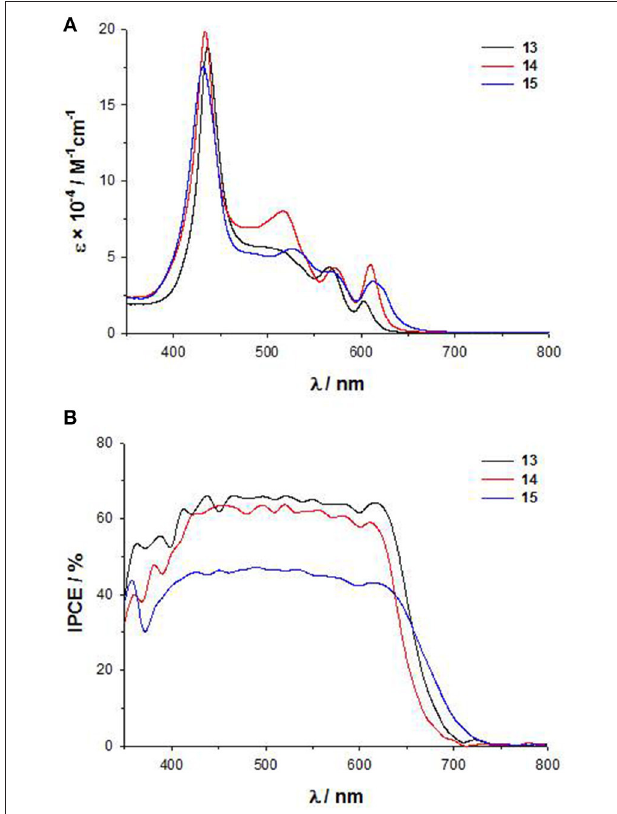
FIGURE 8 | (A) UV-Vis spectra in THF solution of 13-15 ; (B) IPCE spectra of 13-15 .